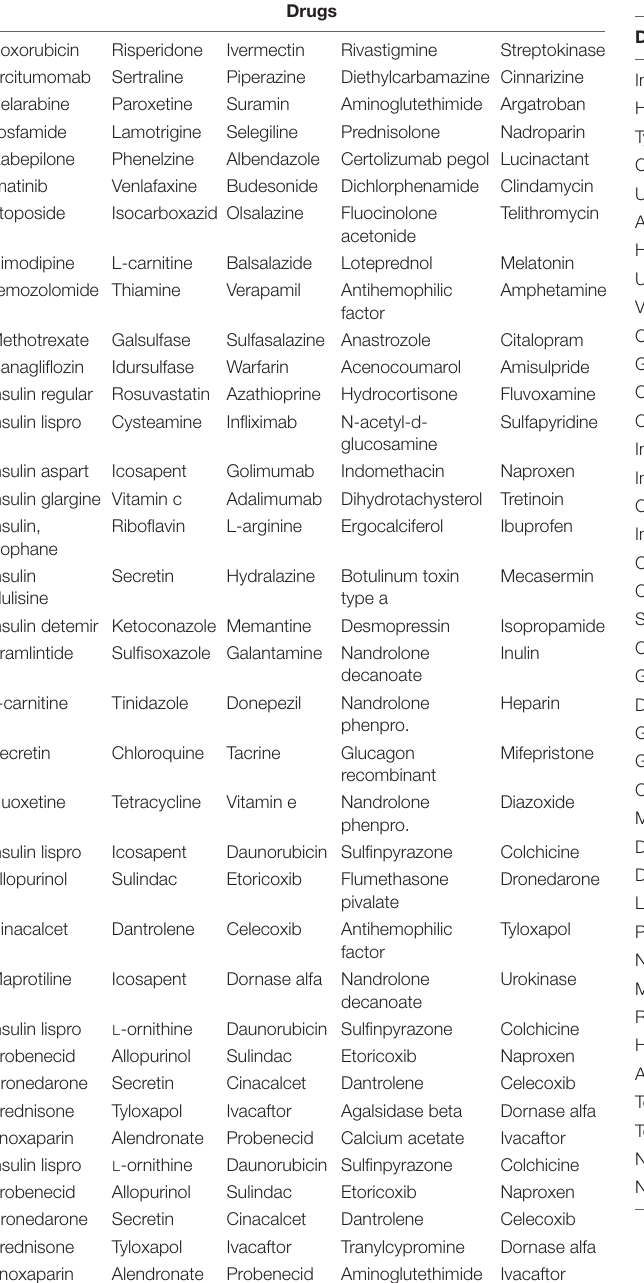
TABLE 4 | Significant drugs used for treatment of diseases listed in Table 2 . TABLE 5 | Possible drugs for repurposing for muscle atrophy treatment predicted by random walk network feature and